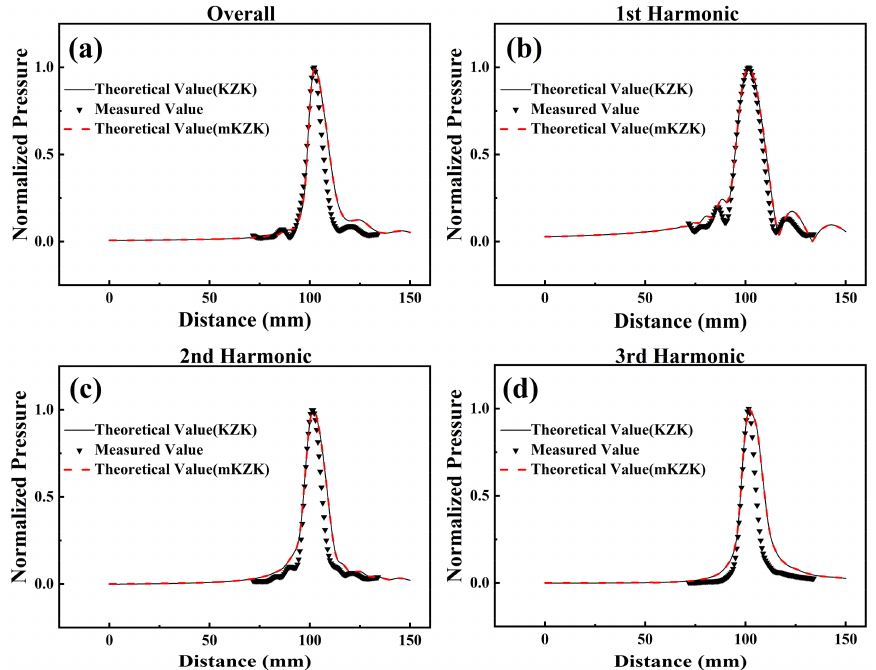
Figure 2. The normalized acoustic pressure distributions along the axis of the HIFU transducer without the phantom: ( a ) the overall pressure; ( b ) the fundamental component; ( c ) the second harmonic; ( d ) the third